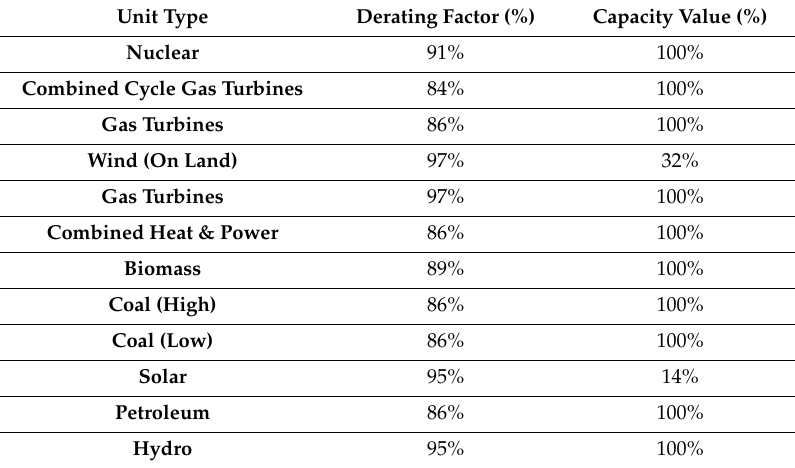
Table A3. Unit Derating and Capacity Value Percentages (Cambridge Energy Solutions, 2011) (U.S. Energy Information Administration, 2015).